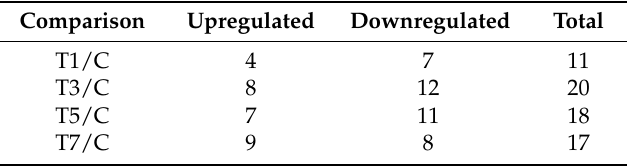
Table 2. Number of differentially expressed circRNAs following grass carp reovirus (GCRV) infection.